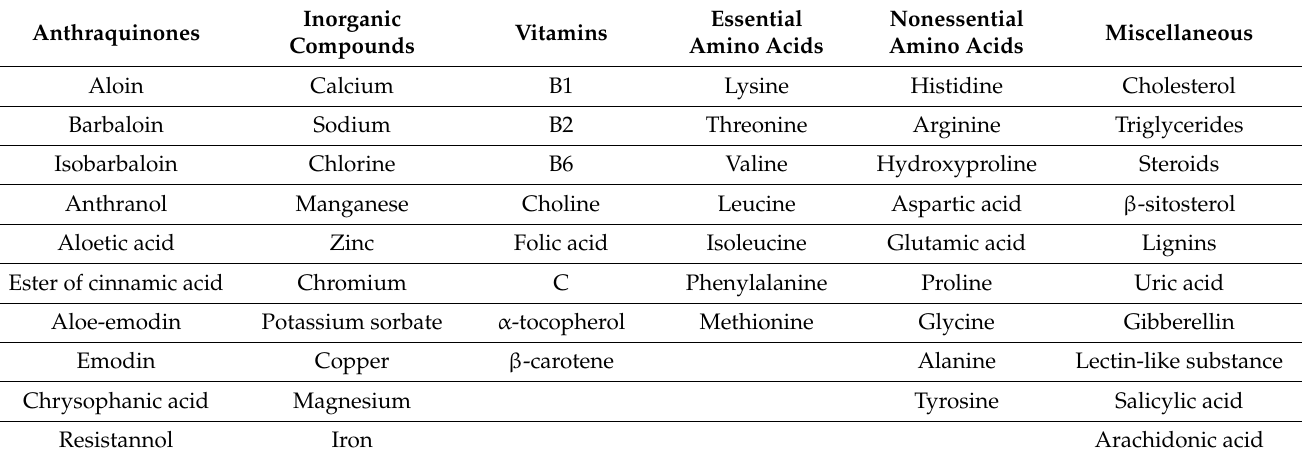
Table 6. Major constituents of Aloe vera (Adapted from